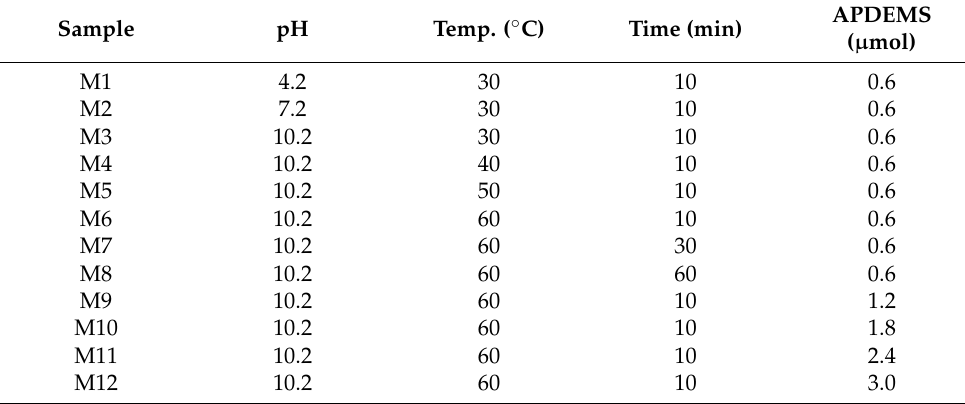
Table 1. Reaction conditions for various pHOP-NH 2